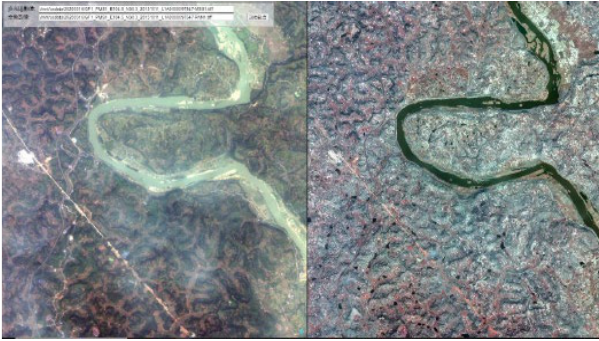
Figure 8. The dynamic fusion of panchromatic and multi- spectral images 4.